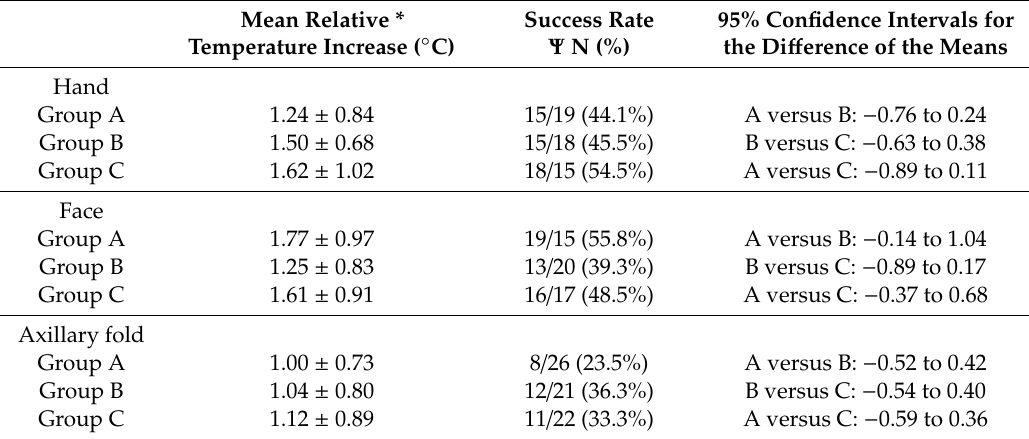
Table 2. Relative temperature increase and success rate at 30 min by measurement site.